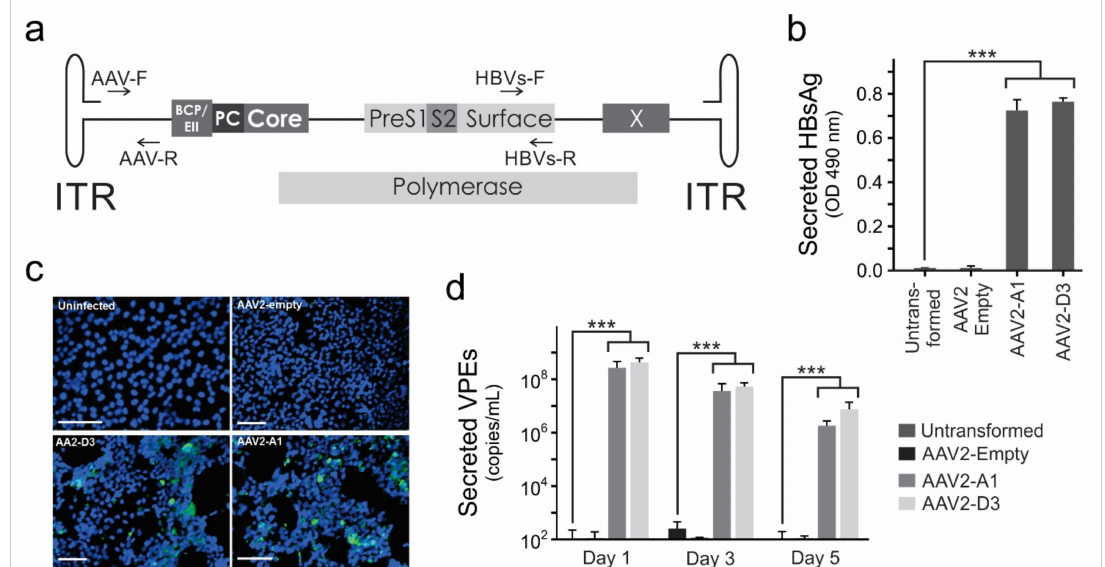
Figure 1. Hepatitis B (HBV) gene expression in liver-derived cells transduced with HBV genome-bearing single stranded adeno associated viral vectors (ssAAVs). ( a ), Schematic illustration of ssAAV genome used to deliver HBV greater-than- genome-length of subgenotype A1 or D3. The PCR primers for quantification of adeno associated viral vector (AAV) viral particle equivalents (VPEs) (AAV-F and AAV-R) and total VPEs (HBVs-F and HBVs-R) are indicated. ( b ), HBV